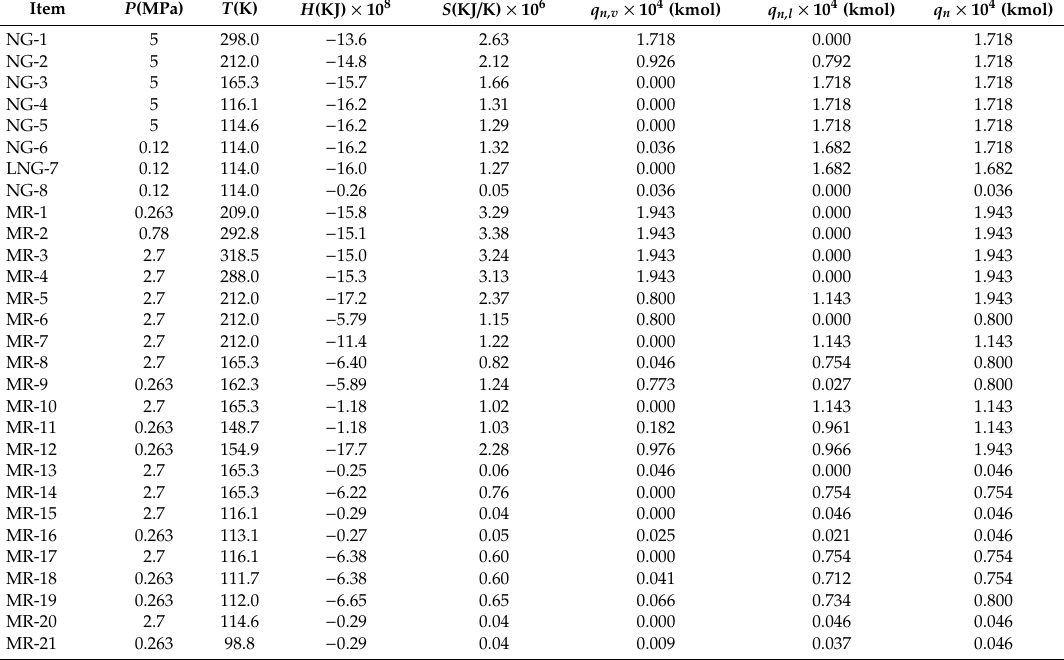
Table A2. Parameters of each node after